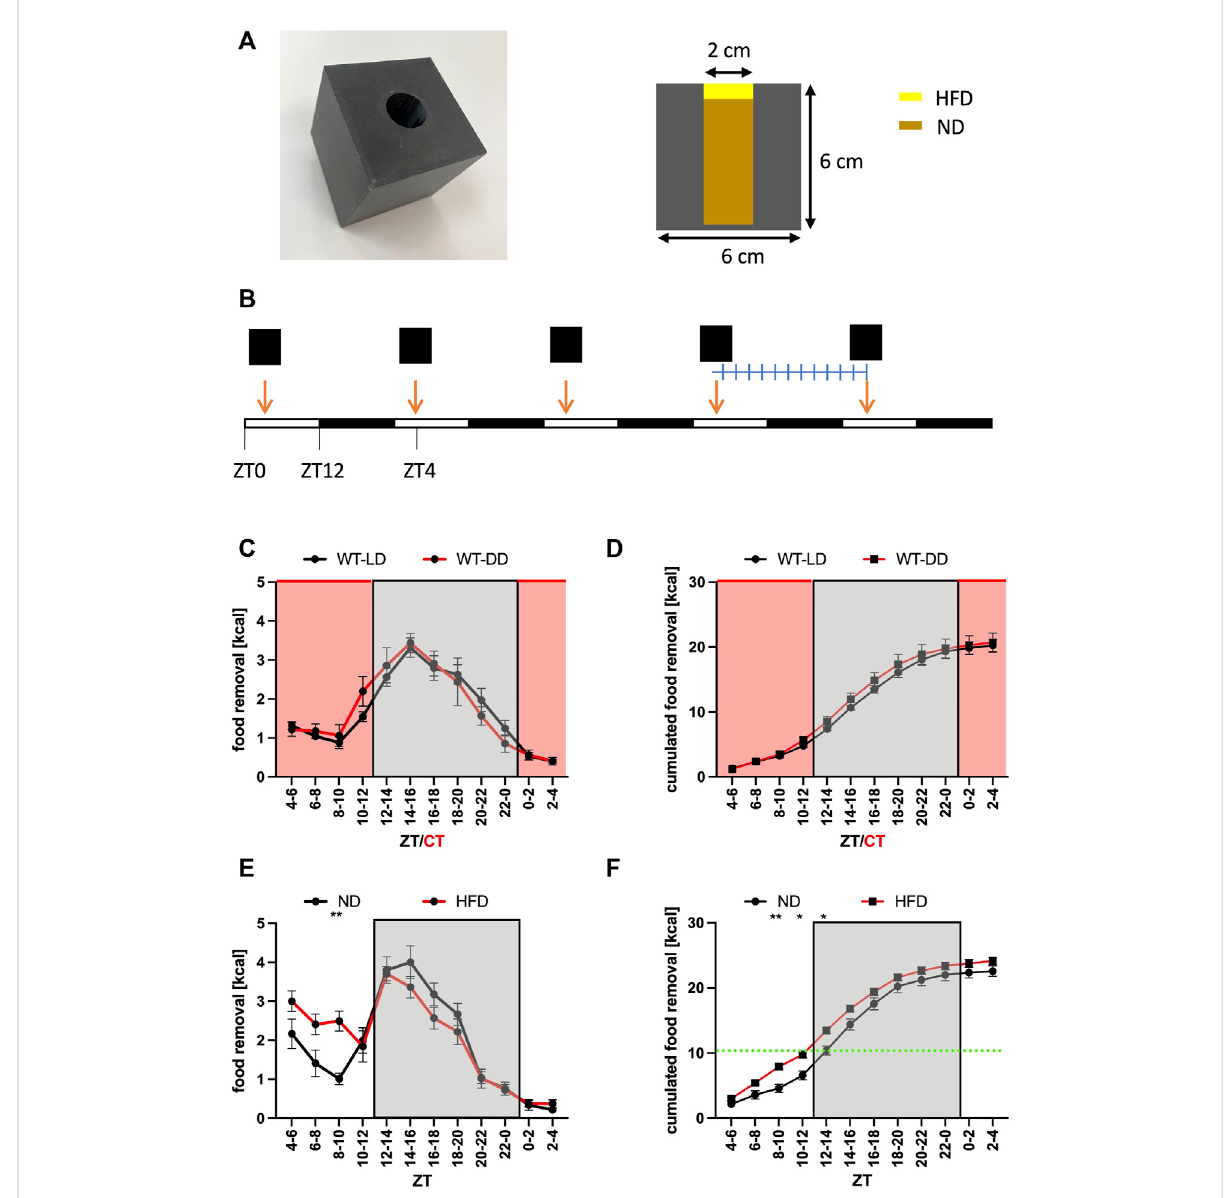
Normal food removal is not affected by the presence of light. (A) Picture and dimensions of the feeding cube. The animals have access to food ad libitum . Note that in some experiments high-fat diet was placed on top of the hole. (B) Outline of the experiment. The cube is replenished every dayatZT4.Afteranentrainmentperiod,theweightoftheboxisdeterminedevery2 h. (C) Foodremovalineach2 hbinstartingfromZT4-6forWTin 12 h light/12 h dark (LD, black) or 12 h dark/12 h dark (DD, red) conditions (2-way repeated measure ANOVA, N = 12, p = 0.8, F = 0.06, DFn = 1, DFd = 22). (D) Accumulation of food removal over the course of the experiment 1C (2-way repeated measure ANOVA, N = 12, p = 0.51, F = 0.44, DFn = 1, DFd = 22). (E) Food removal in each 2 h bin starting from ZT4-6 for WT with normal diet (black) or high-fat diet (red) (2-way repeated measure ANOVA, N = 12, p = 0.85, F = 0.03, DFn = 1, DFd = 22). (F) Accumulation of food removal over the course of the experiment 1E (2-way repeatedmeasureANOVA,N=12, p